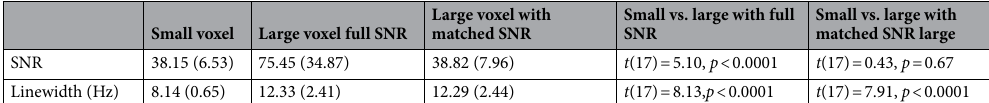
Table 2. Quality metrics of the voxels. Signal to Noise Ratio (SNR) calculated with the height of the tNAA peak to the signal at 0 to -2 ppm. Linewidth is the width of the water peak in Hz. Both calculated using FID- A 12 . Values are means with standard deviations in